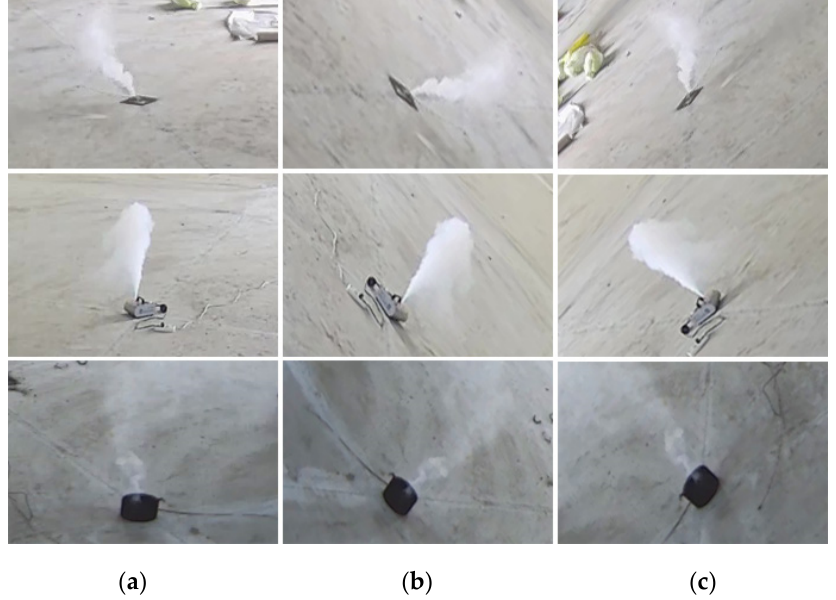
Figure 7. Data enhanced images. ( a ) The images were made horizontal flip; ( b ) The images were rotated 45 degrees; ( c ) The images were rotated 315 degrees.